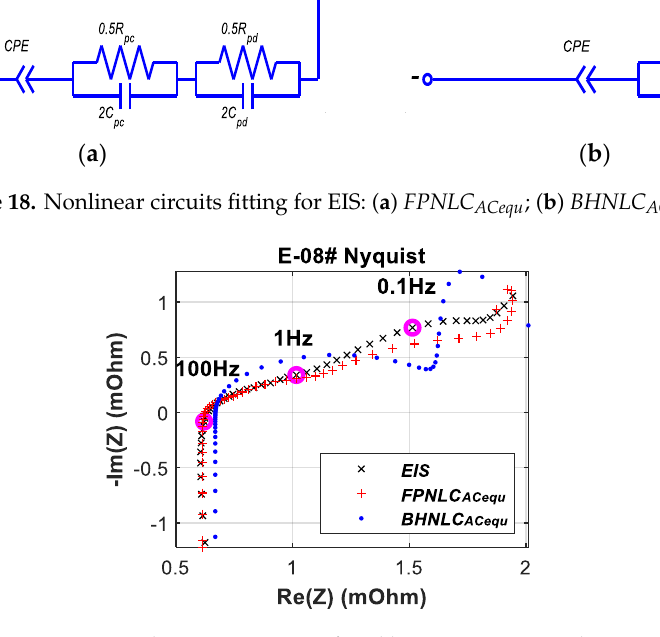
Figure 19. Experimental Nyquist curve is fitted by FPNLC ACequ and BHNLC ACequ . Table 3. Values of elements in Figure 18.